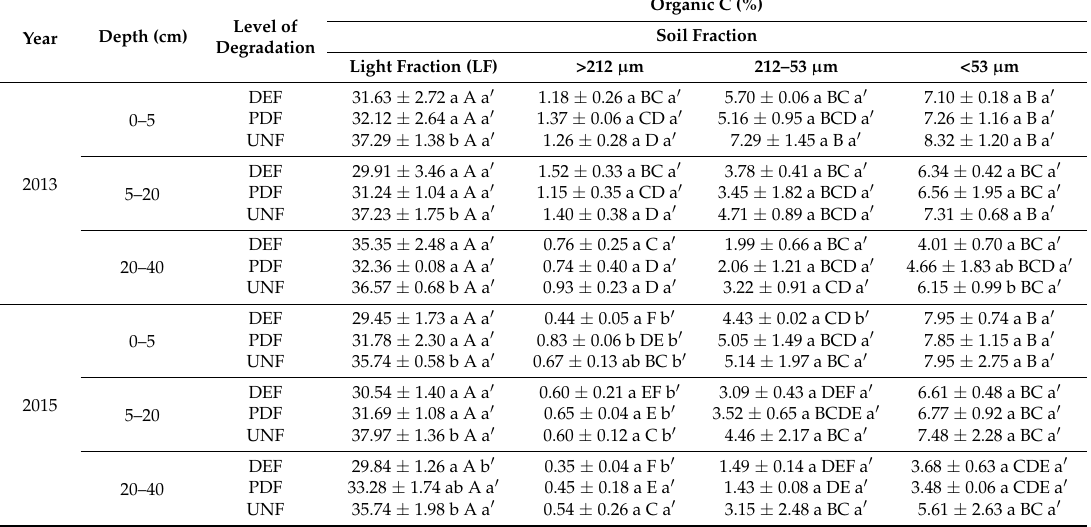
Values with the same lower case letter among levels of degradation and within a same year, depth, and soil fraction are not significantly different (Student’s t test, ** p < 0.01). Values with the same higher case letter among the three depths and one level of degradation between distinct soil fractions are not significantly different (Tukey’s HSD test, * p < 0.05). Values with the same lower case letter (a (cid:48) or b (cid:48) ) between years and within a same depth, level of degradation, and soil fraction are not significantly different (Student’s t test, * p <